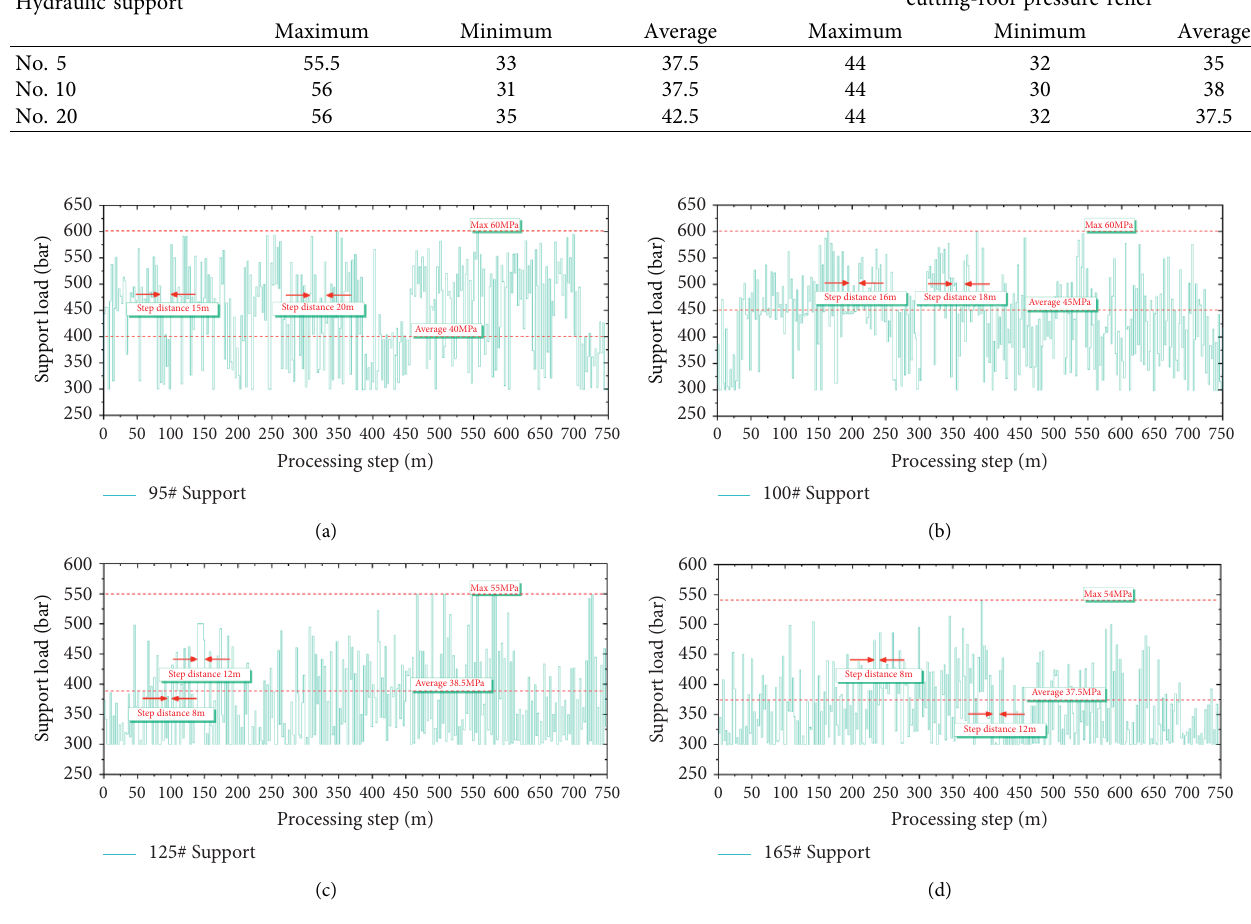
Figure 6: Pillar load curves of supports in the middle unaffected area and uncut top area: (a) No. 95, (b) No.100, (c) No.125, and (d) No.165. Table 3: Support load and periodic pressure step in the middle of the unaffected area and uncut top area. Area